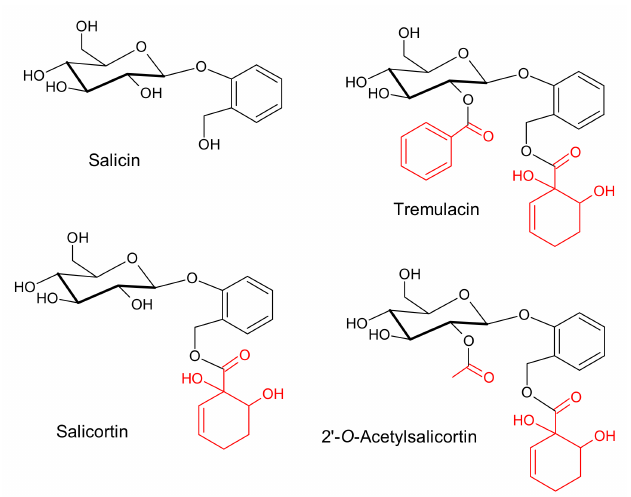
Figure 1. Molecular structure of salicin and its derivatives; salicin core (black) and structural modifi- cations in the dominant derivatives are highlighted in